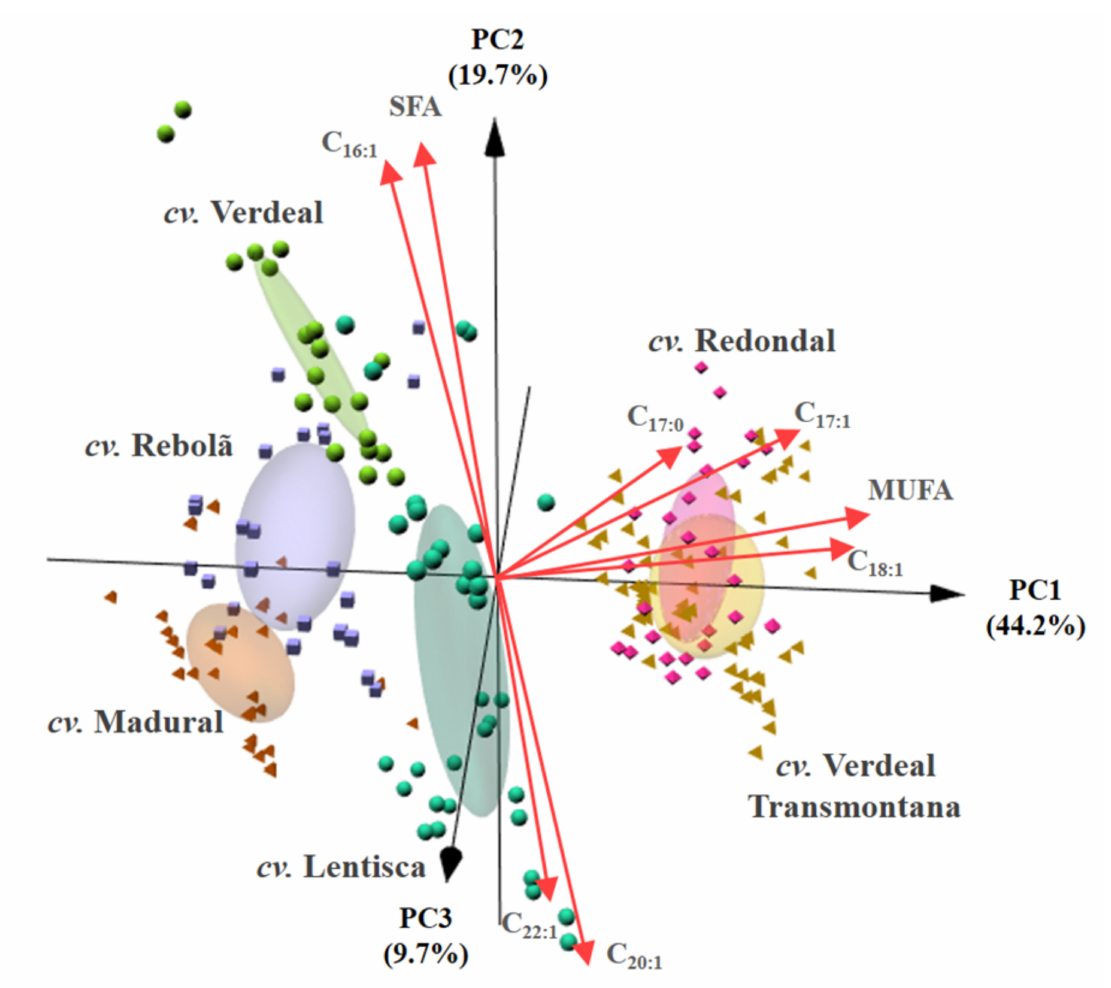
Figure 1. Principal component analysis (PC1: 44.2%, PC2: 19.7%, and PC3: 9.7%) based on the fatty acids profile (C 14:0 , C 16:0 , C 16:1 , C 17:0 , C 17:1 , C 18:0 , C 18:1 , C 18:2 , C 18:3 , C 20:0 , C 20:1 , C 22:0 , C 22:1 , C 24:0 , SFA, PUFA, and MUFA proportions): 3D biplot showing the unsupervised pattern recognition according to olive cultivar (cvs. Lentisca, Madural, Rebol ã , Redondal, Verdeal, and Verdeal Transmontana) on the basis of fatty acids composition (%) found in olive oils obtained from olives collected in centenarian trees during five consecutive crop years (2013 to